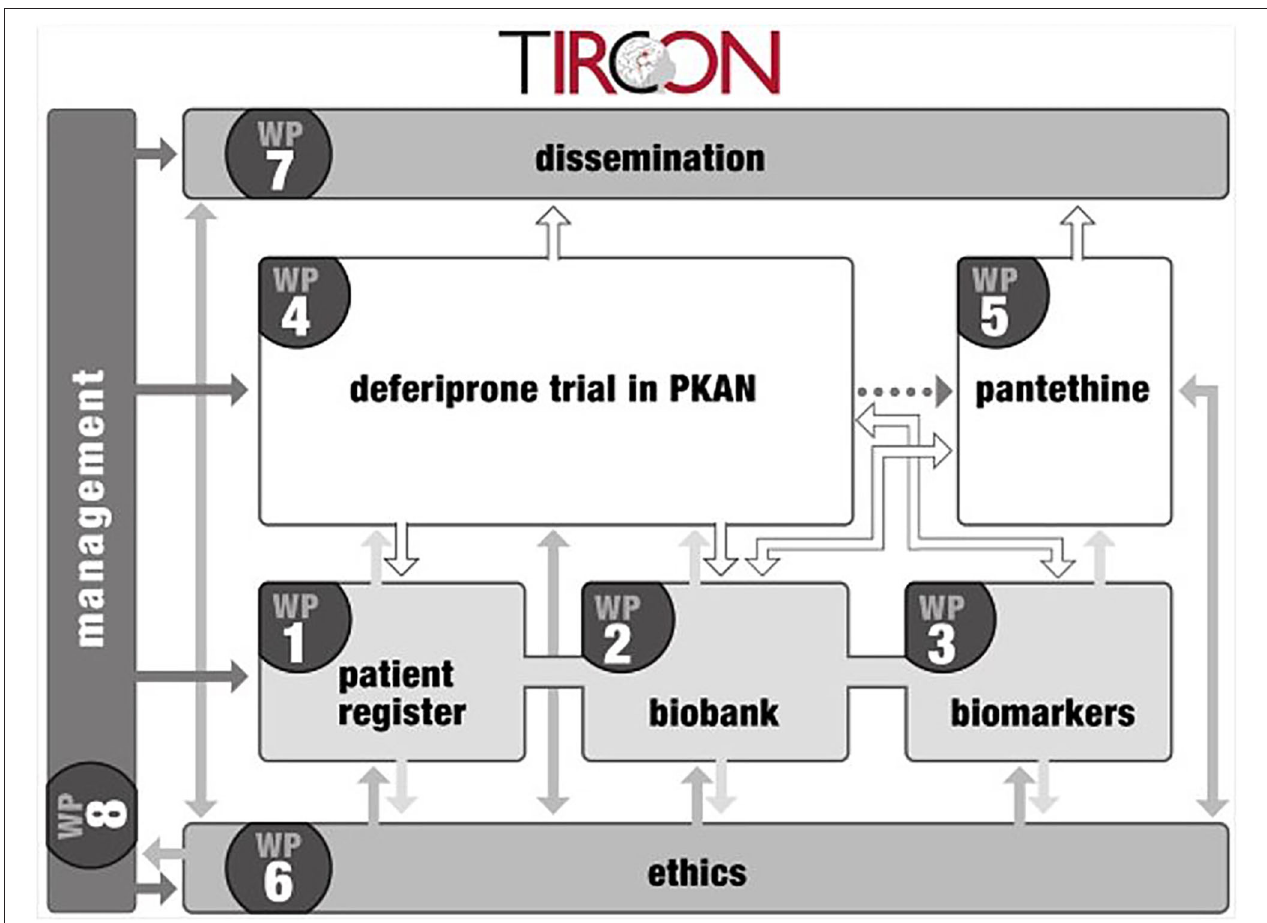
FIGURE 1 | Overview of TIRCON work